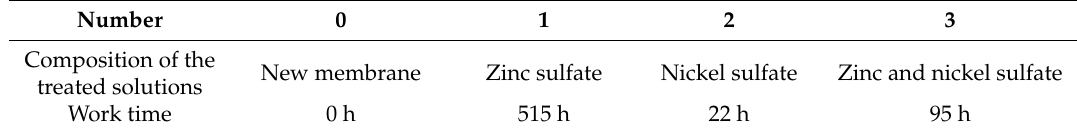
Table 4. Information of the studied membranes.